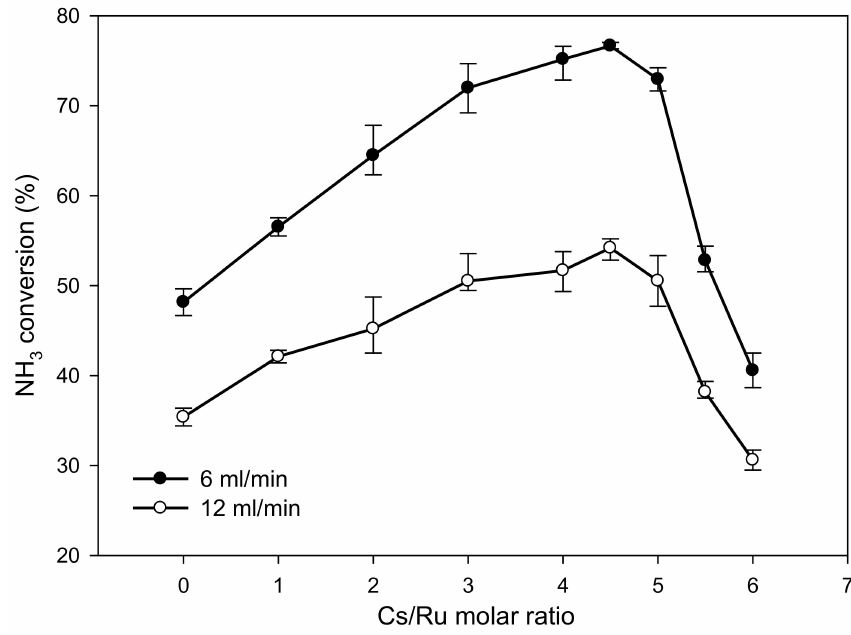
Figure 4. The variation of overall molar ratio Cs/Ru on the ammonia conversion using Ru/C catalyst at temperature of 350 ◦ C and Ru loading of 1.39